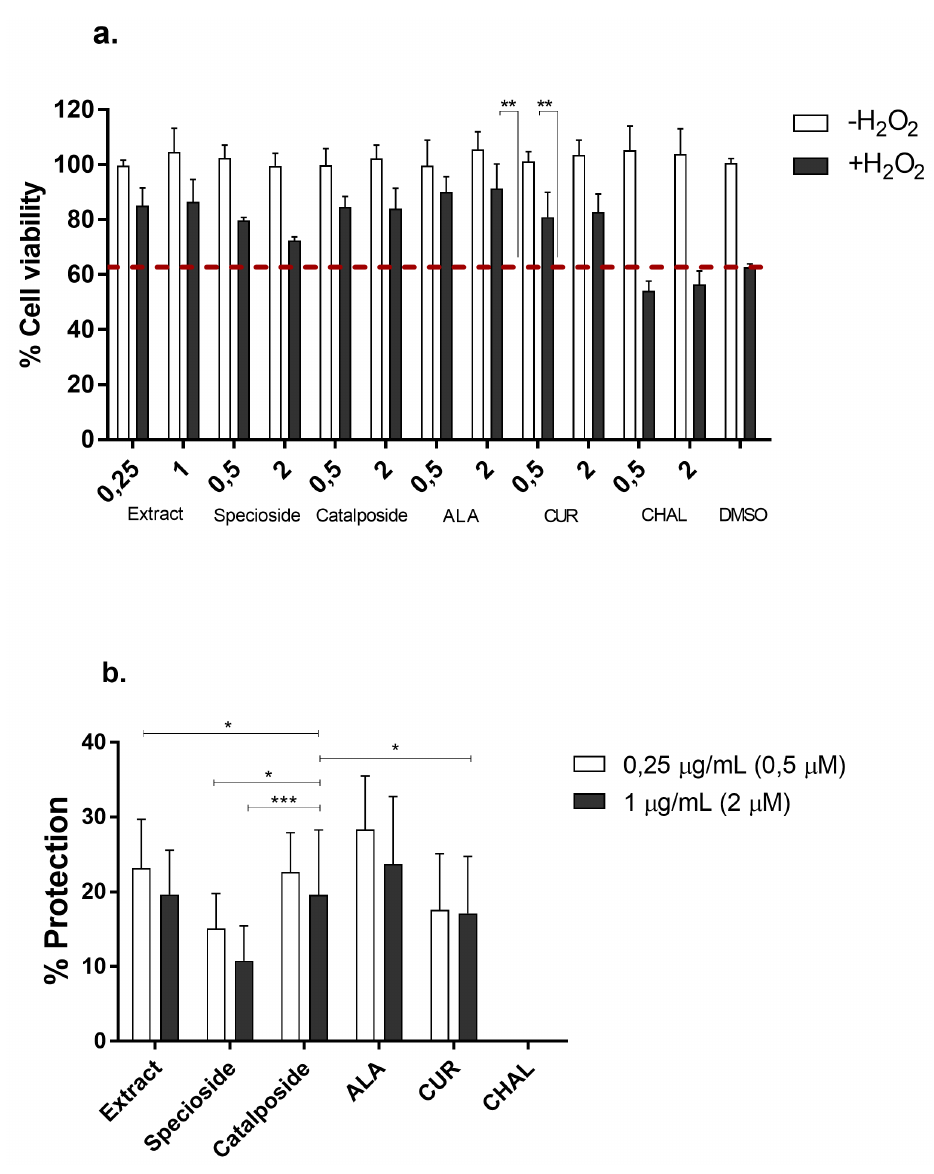
Figure 6. Effect of the n -butanol extract, pure compounds and controls on the HepG2 cell line against H stress. a . Percentage of cell viability. b . Protective effect. Kruskal-Wallis, Dunn’s post hoc. * p<0.05, ** p<0.01, *** p<0.001. ALA, α-lipoic acid; CUR, curcumin; CHAL,